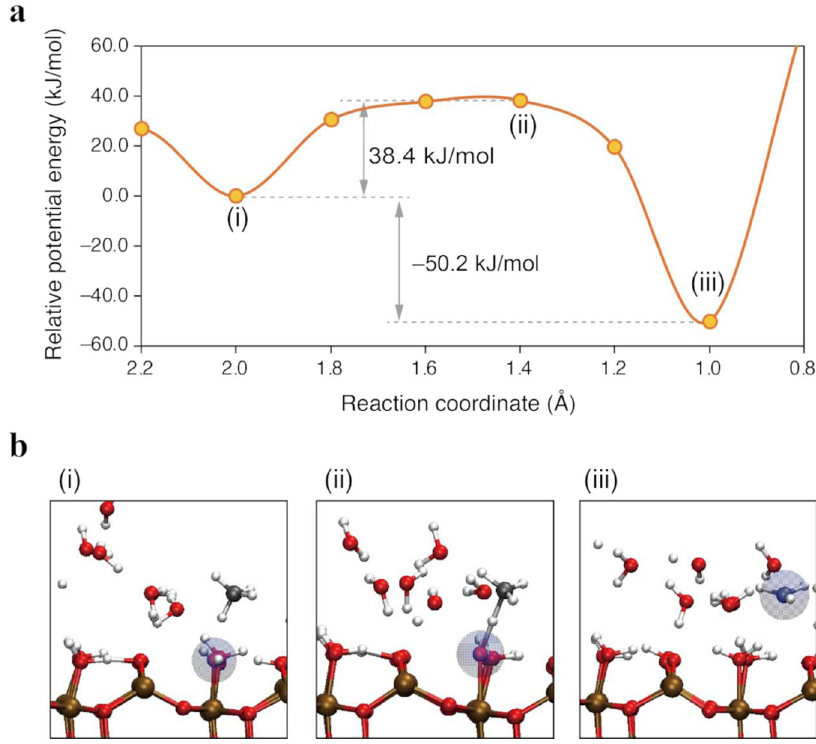
Fig. 3 Ab initio molecular dynamics simulation results. a Potential energy curve (PEC) and b snapshots corresponding to the dots on PEC (i – iii) for methane activation under wet conditions on a β -Ga 2 O 3 surface. The blue-shaded spheres in the snapshots indicate the hole, which is identi fi ed from a Mulliken spin population value larger than 0.5